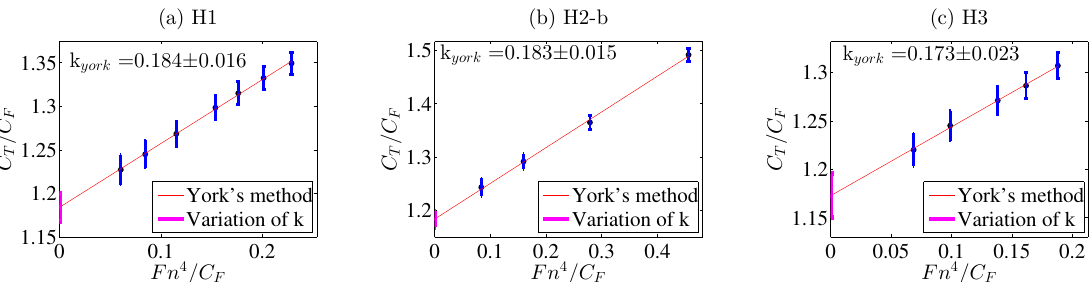
Figure 12. Prohaska plot of test cases in ballast loading condition: ( a ) H1, ( b ) H2-b, ( c ) H3.